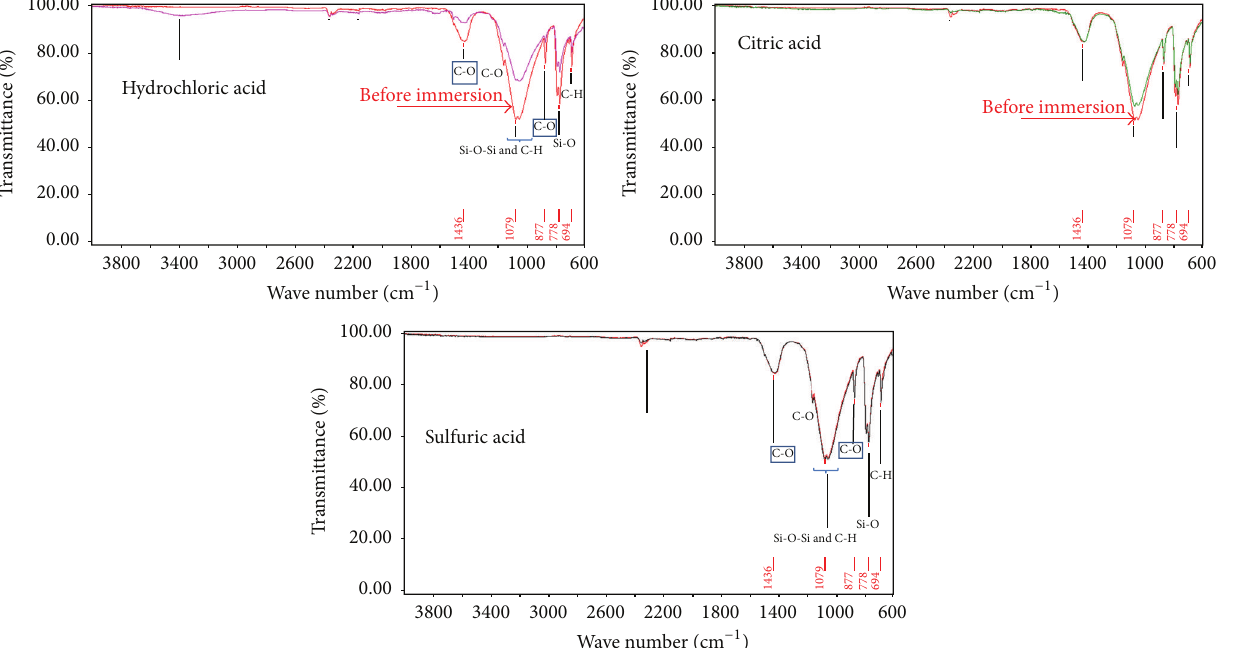
hydrates) cause the destruction of cement hydrates and therefore the material